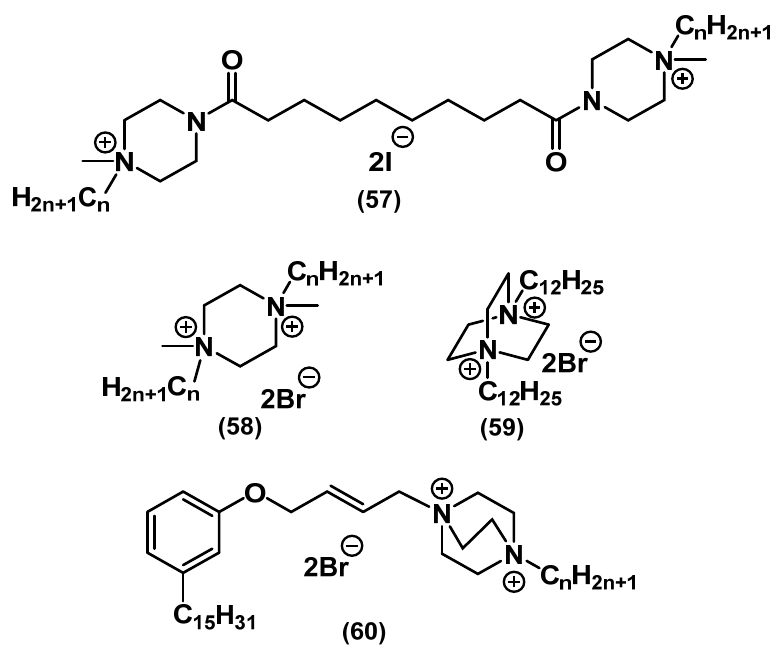
Figure 22. Bis-QACs containing saturated heterocycles.